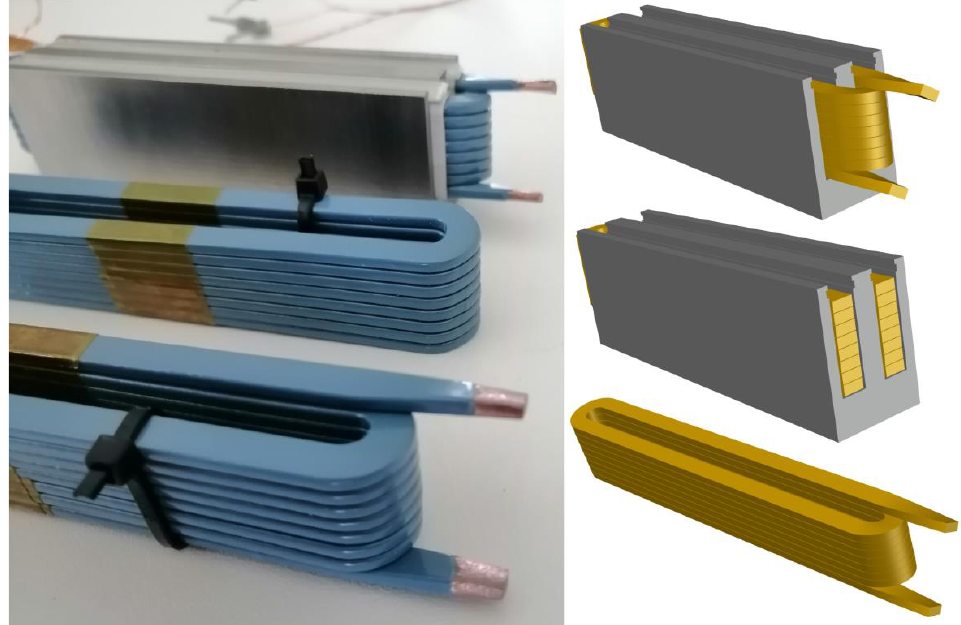
Figure 9. Reference coil case: 3D printed pure copper coil and assembly with a ferromagnetic core.